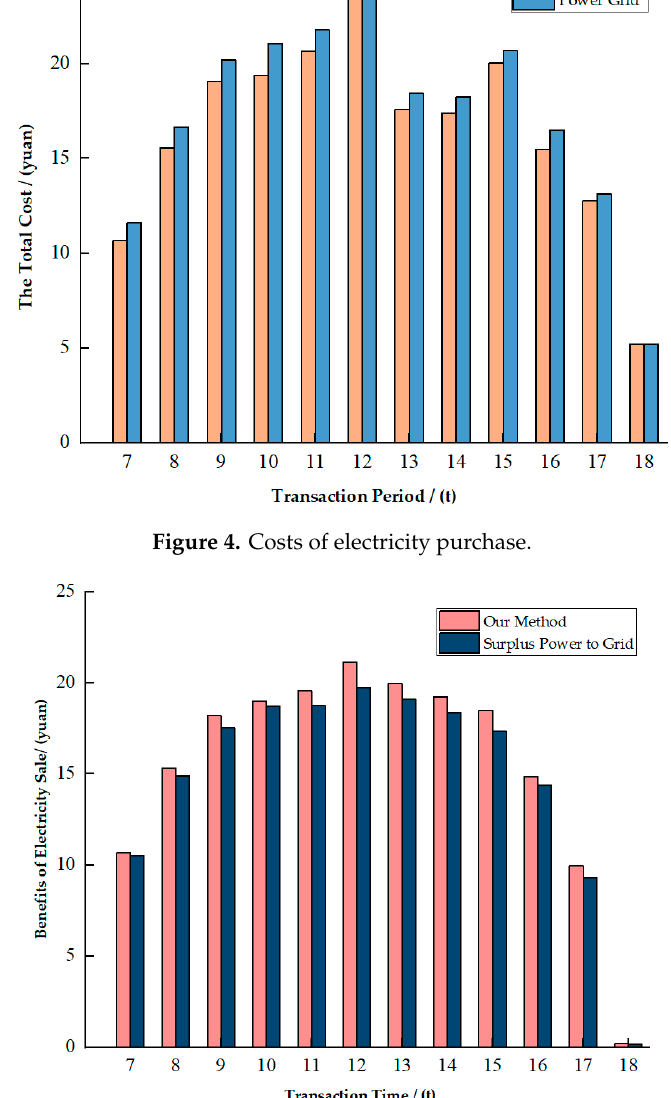
Figure 5. Benefits of electricity sales.